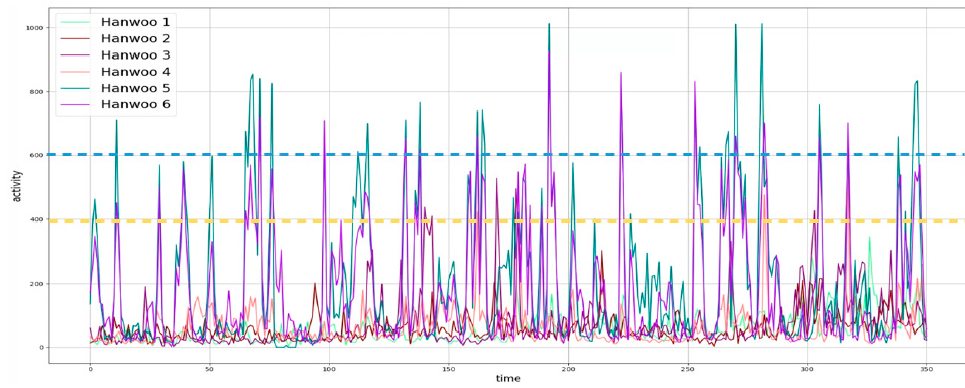
Figure 10. Activities of individual Hanwoos.